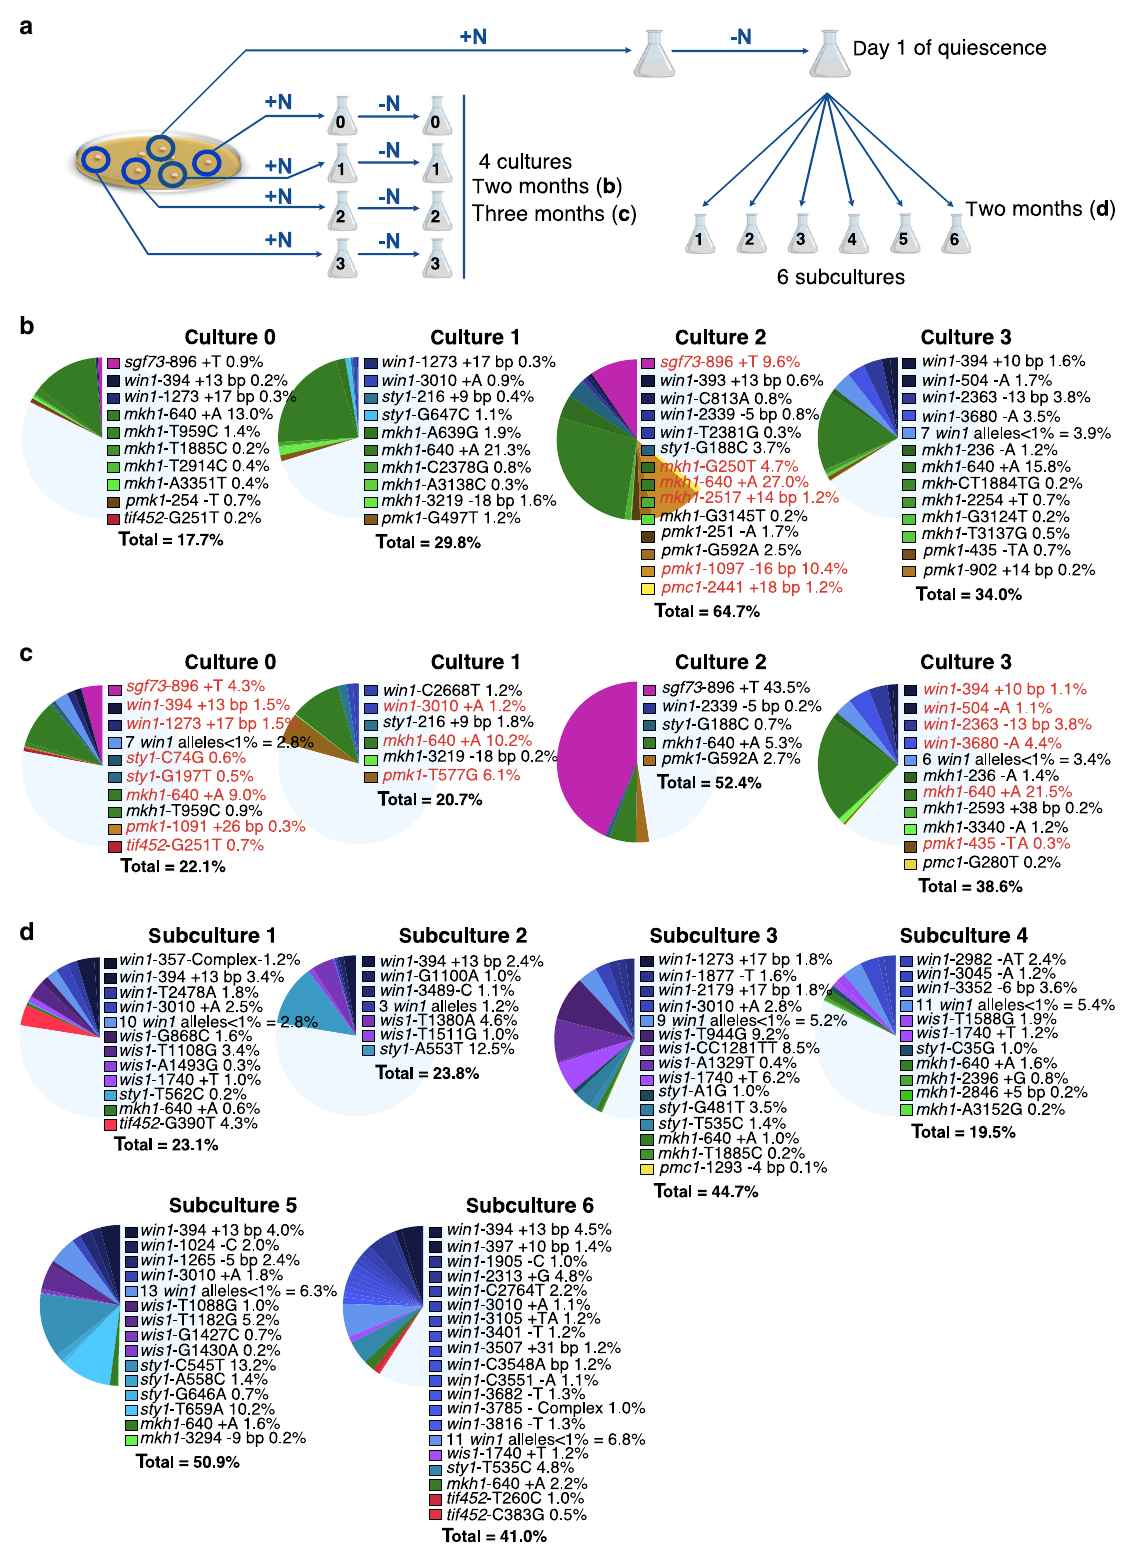
Fig. 2 Targeted resequencing of genes in the S/MAPK pathways. a Schematic view of the strategy used to obtain nitrogen-starved cultures. The same progenitor strain was used to grow ( + N) three independent cultures (in addition to culture 0) prior to shifting to quiescence ( − N) (left panel). The same approach was used to grow a single culture prior to splitting on day 1 of quiescence into six parallel subcultures (right panel). Samples were analyzed after 2 and 3 months of starvation. b Distribution and percentage of mutations found in the thousand colonies picked from cultures 0 to 3 after 2 months. The alleles in red were con fi rmed by Sanger sequencing the stress-sensitive colonies found among 120 cells plated out from the frozen pools. c same as b after 3 months. d Distribution and percentage of mutations in the subcultures after 2 months of